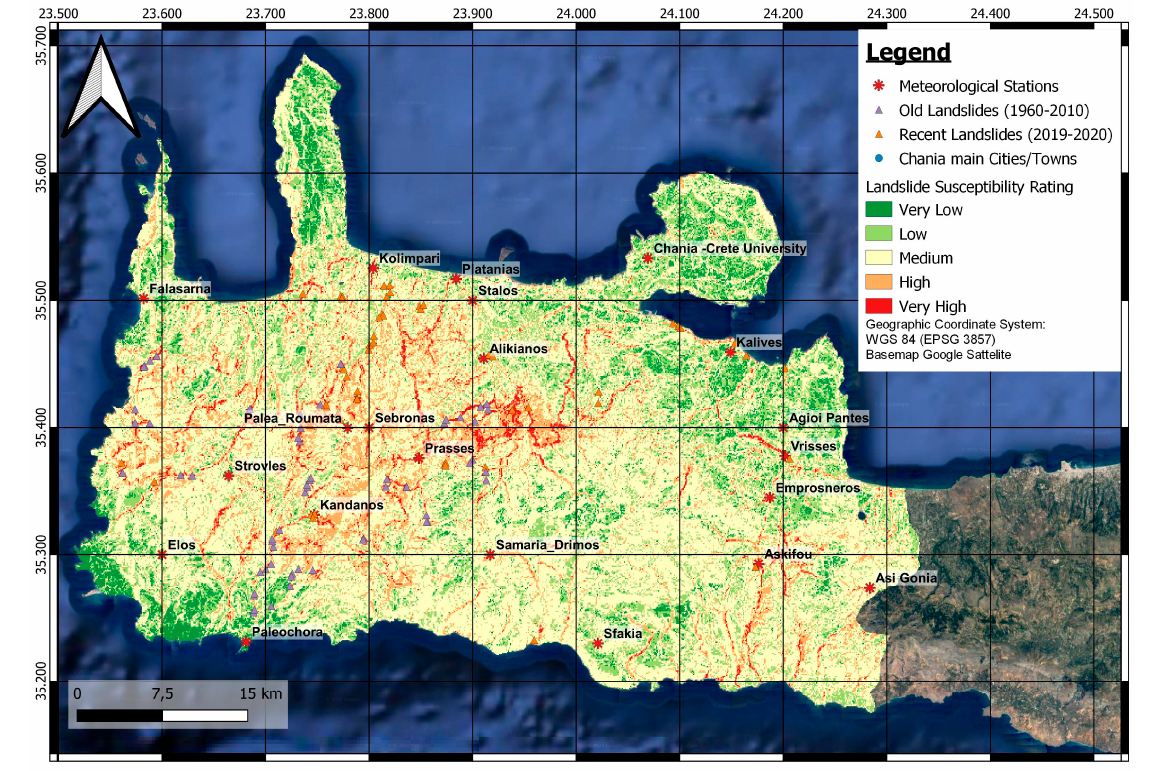
Figure 15. Total landslide susceptibility map (LSM) for the Chania regional unit using MAP-10.